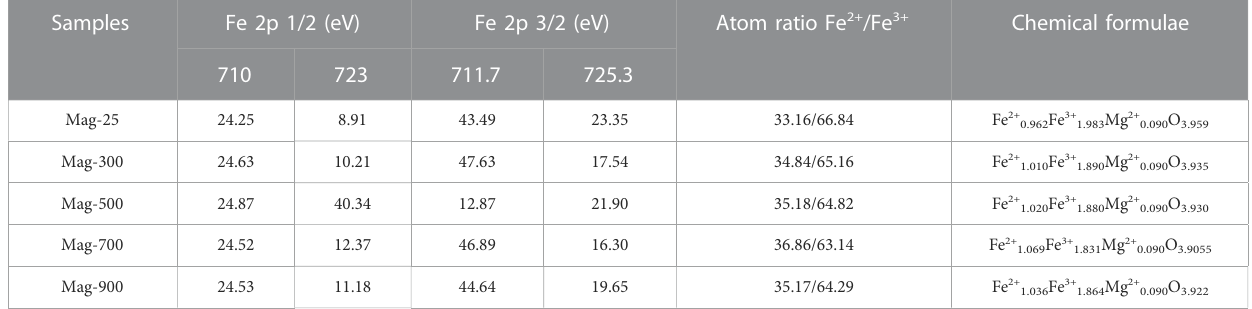
TABLE 8 Related content of Fe 2+ and Fe 3+ in series materials and the given structural formulae.